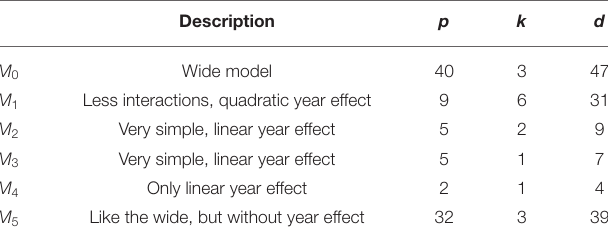
TABLE 2 | Brief descriptions of the wide model and the five additional candidate models, with the number of fixed effects, the number of random effects, and the total number of parameters to be estimated, for each